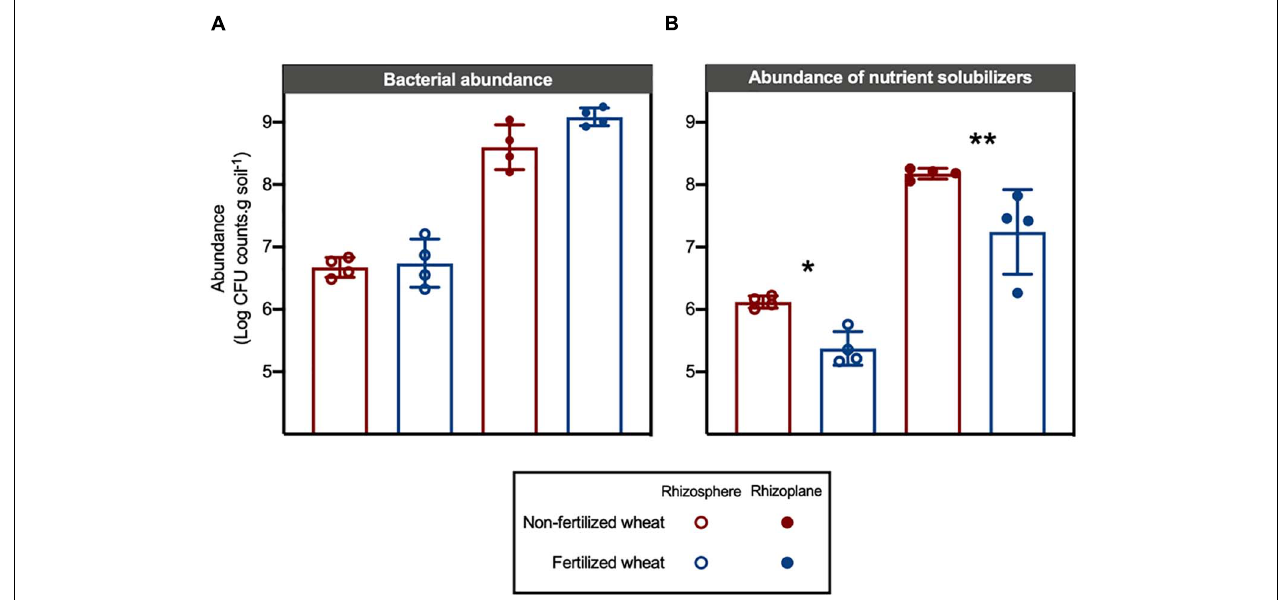
FIGURE 5 | Effect of chemical fertilizer (NPK) on absolute abundance of culturable bacteria isolated from the rhizosphere and rhizoplane of wheat grown in low nutrient soil. (A) Absolute abundance (log CFU counts.g soil − 1 ; CFU is colony-forming units) of culturable rhizobacteria isolated from soil samples on 10TSA.